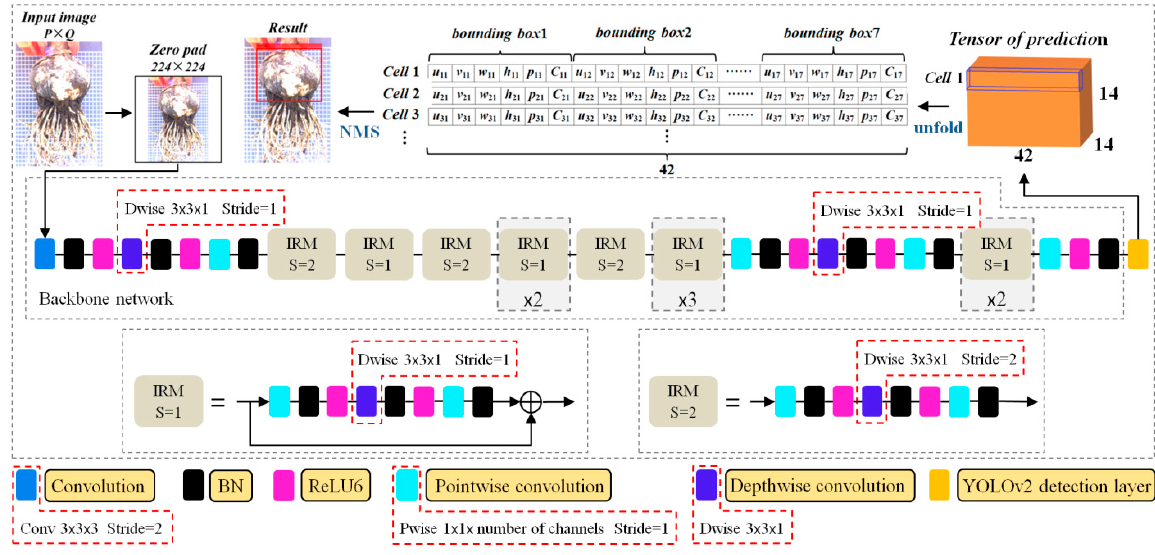
Figure 5. IRM-YOLOv2 model structure.